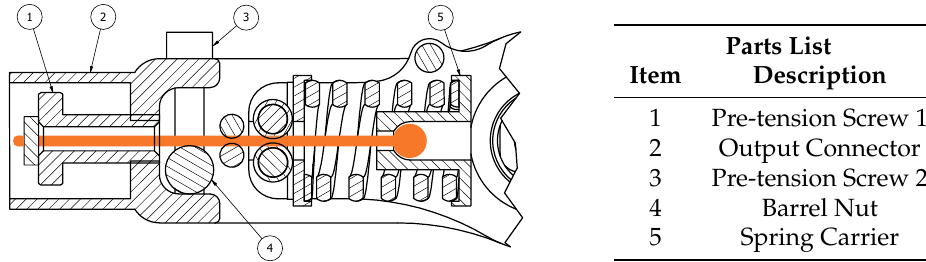
Figure 3. Cross-section view of the SMARCOS presenting the two pre-tension mechanisms of the Dyneema rope (in orange). A first pre-tension screw, situated in the output connector, is used to tension the rope during the assembly, and for the rough tensioning of the cable. Next to this, a second pre-tension screw, which acts on the rope by pulling it with a barrel nut, is used for fine pretension